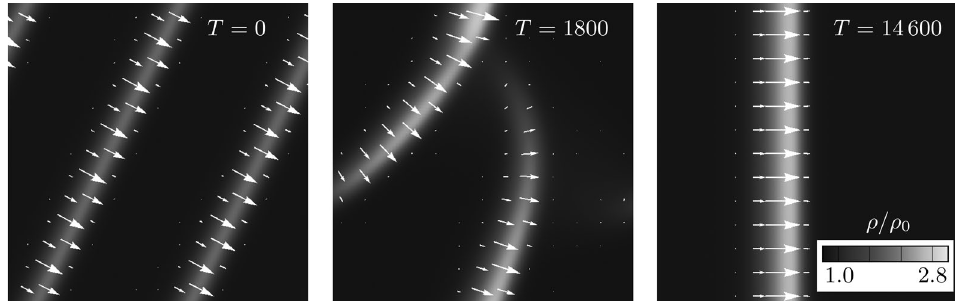
FIG. 9. Illustration of the bending instability in the vicinity of the transition DSP → IHP. Snapshots from left to right are taken at different times T . The left panel indicates the initial extended wave pattern, which becomes unstable toward a bending instability (middle panel); the right panel shows the reinforced stable wave pattern, which is contracted along the lateral dimension, as compared to the initial